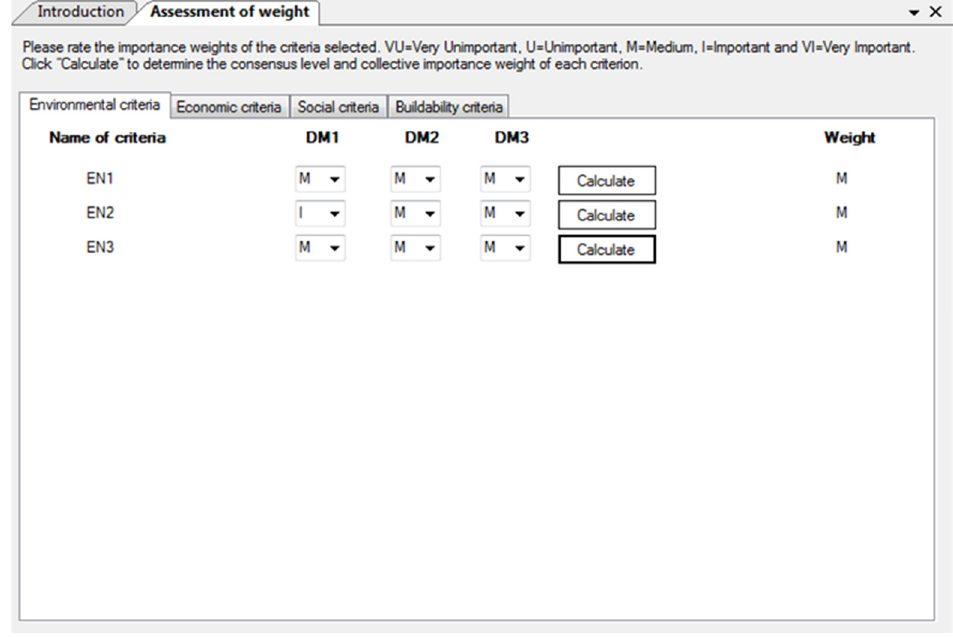
Figure 4. Assessment of the importance weights for all the criteria for the case study